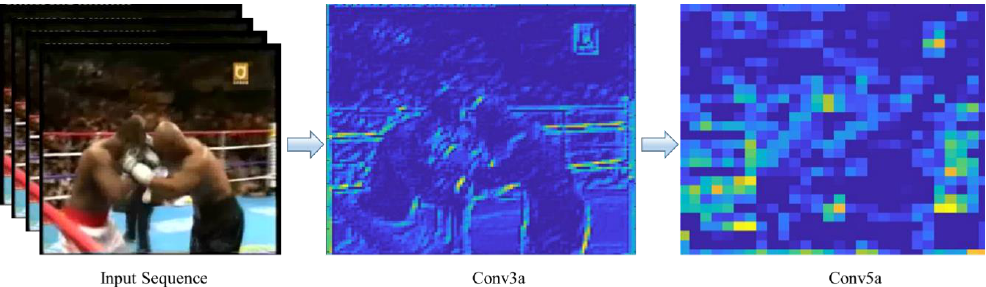
Figure 3. The input sequence is taken from violence in movies dataset. Feature map of the conv3a and conv5a is formed. As the process of the convolution proceeds, deeper features are extracted.